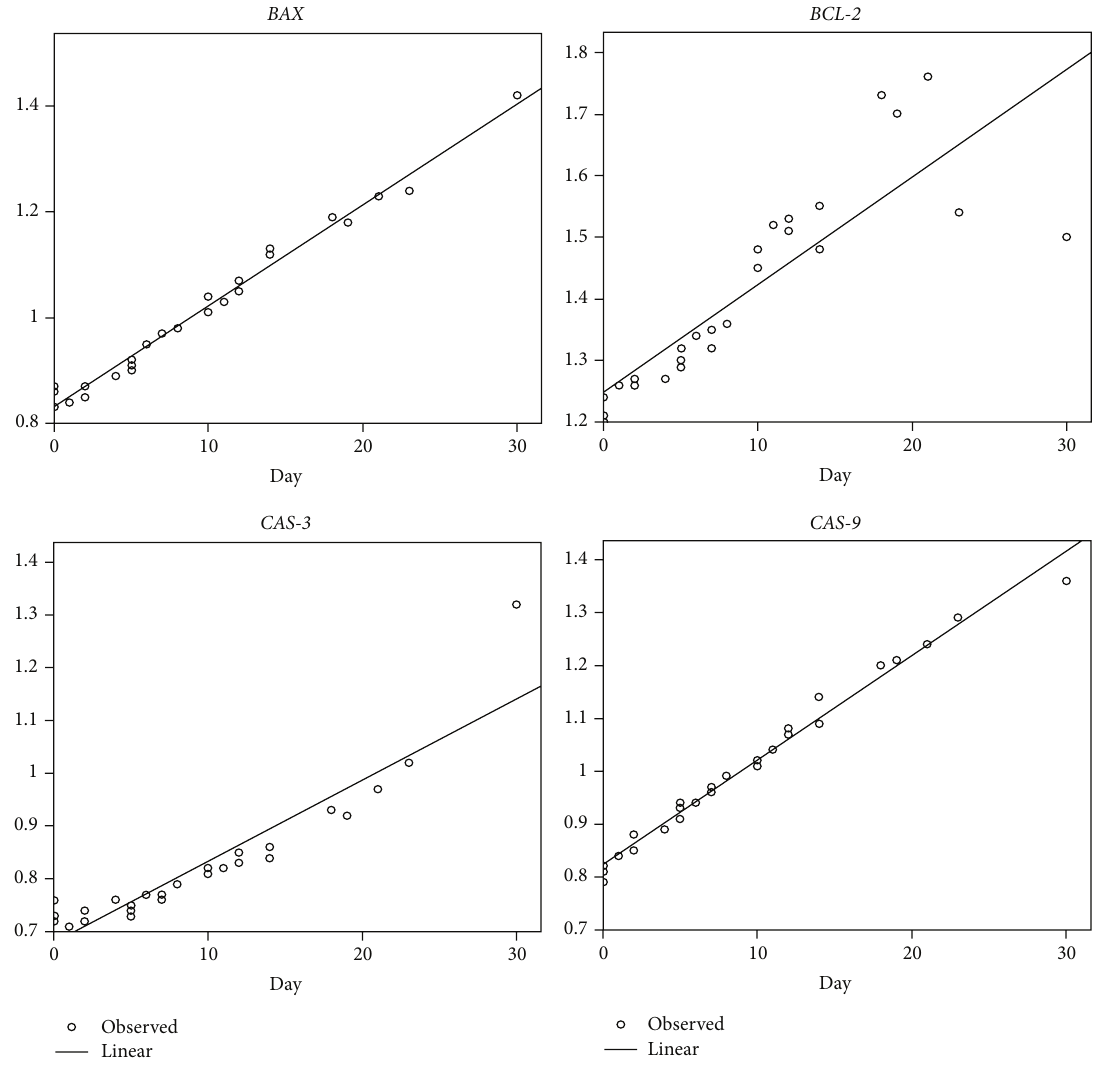
Figure 2: The relationship between relative expression of apoptotic genes and days of luxation ( BAX , Bcl-2-associated X protein; BCL-2 , B-cell lymphoma-2; CAS-3 cysteine aspartate-specific protease-3; CAS-9 , cysteine aspartate-specific protease-9).